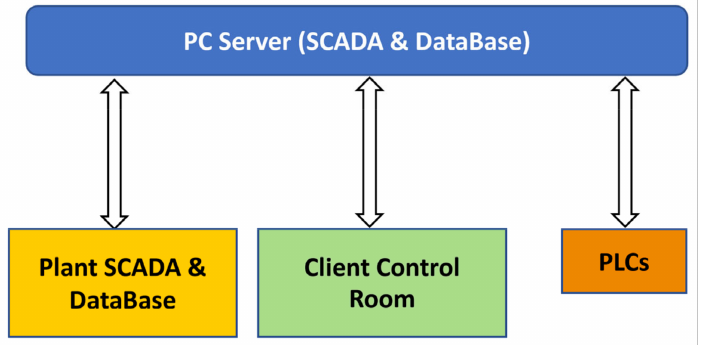
Figure 3. Data acquisition and storage